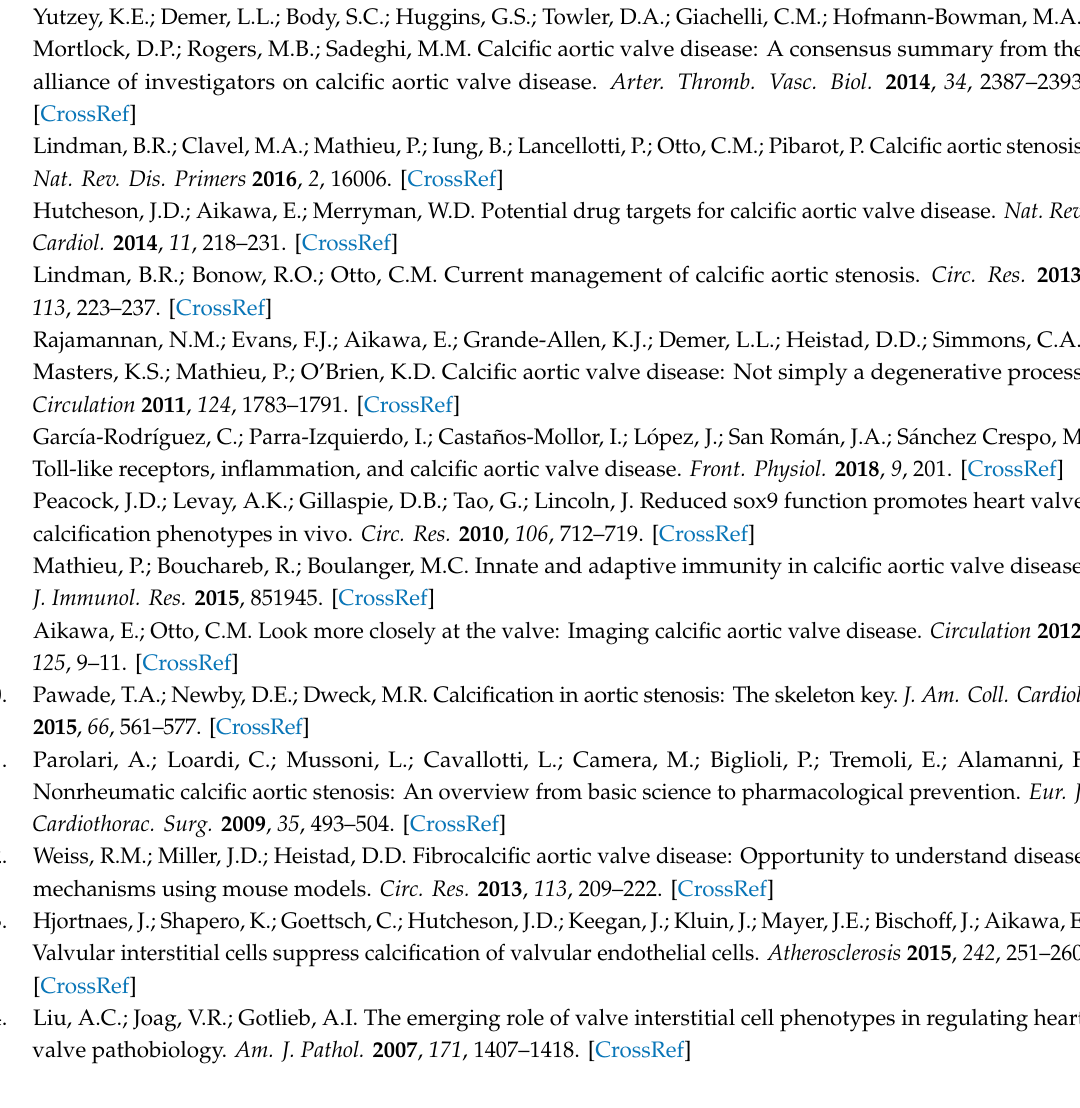
Figure S1: PKR is localized in the cytosol of human AVICs. Human AVICs were treated with recombinant matrilin-2 for 30 min to 1 h. Representative images of immunofluorescence staining show PKR (red) in human AVICs. Alexa 488-tagged WGA (green) was applied to outline plasma membrane. DAPI (blue) was applied for nuclear counterstaining. Original magnification, × 40 objective, Figure S2: PKR inhibitors abolish matrilin-2-induced PKR phosphorylation in human AVICs. Human AVICs were treated with C13H8N4OS or 2-AP for 1 h or left